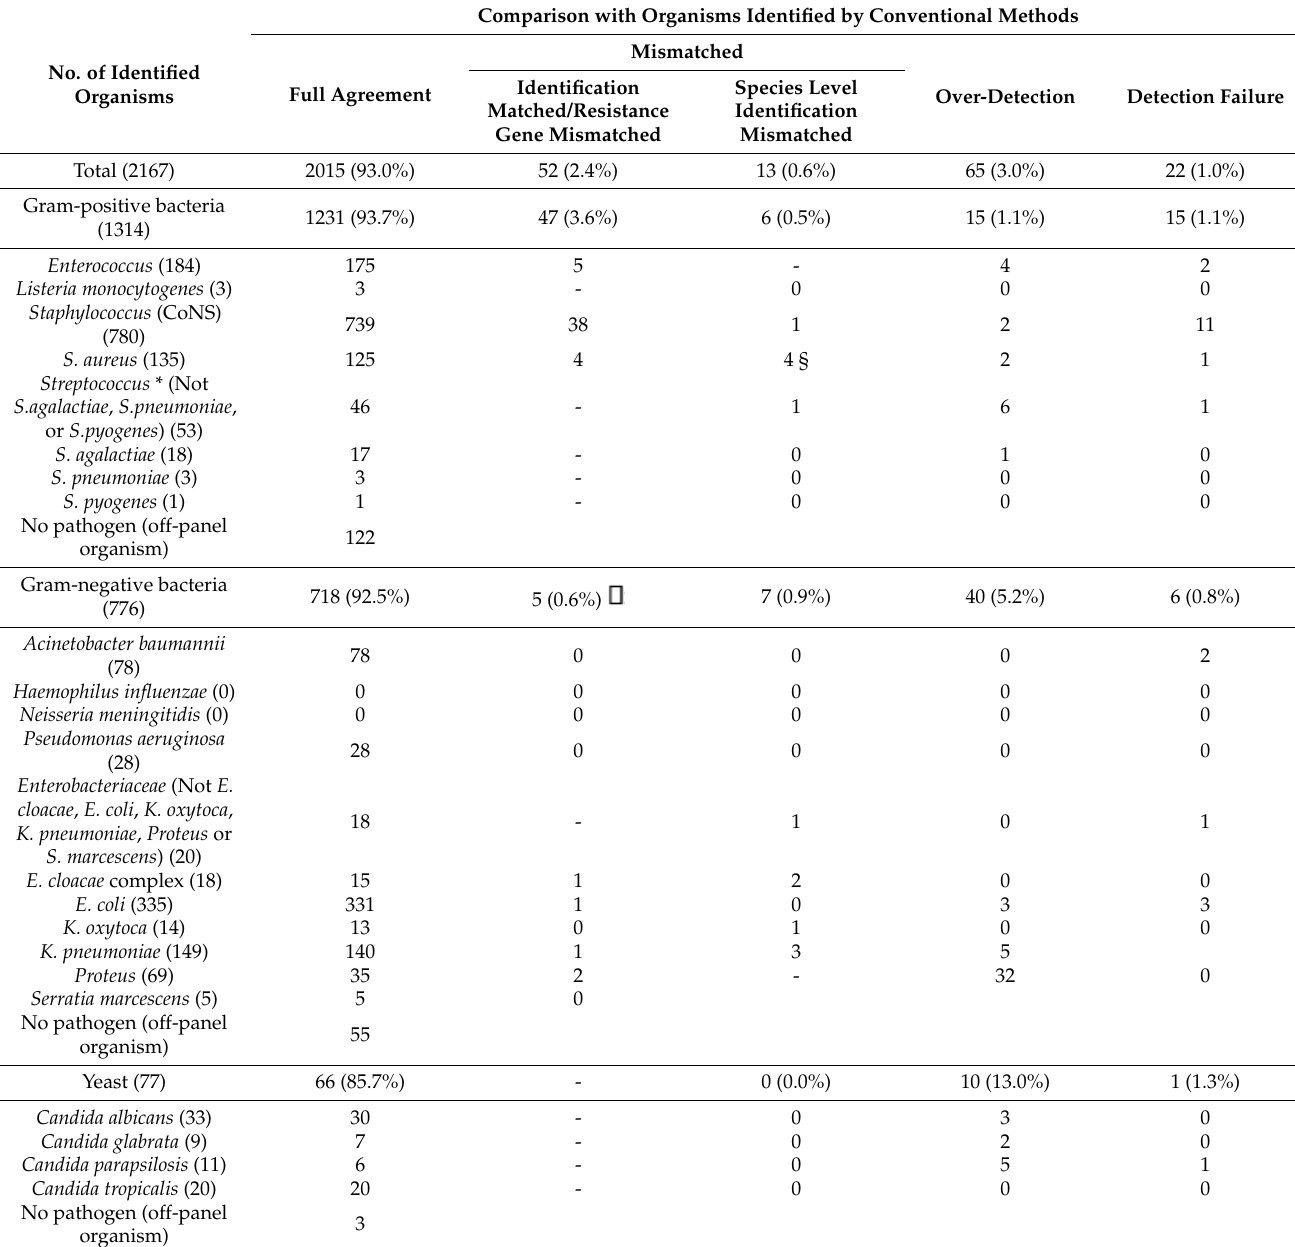
Table 3. Comparison of the identification of microbial pathogens from positive microbial blood cultures between the BCID panel and conventional culture